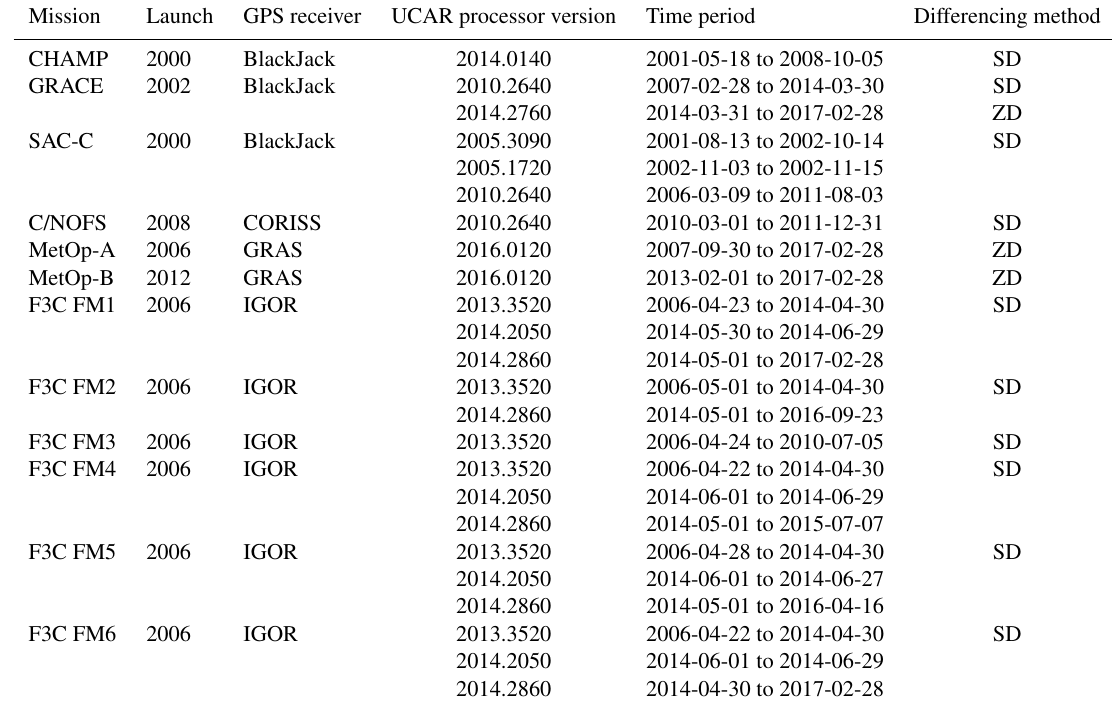
Table 1. Excess phase and orbit input data to the WEGC OPSv5.6 radio occultation data processing. Regarding the differencing methods, SD denotes single differencing and ZD denotes zero